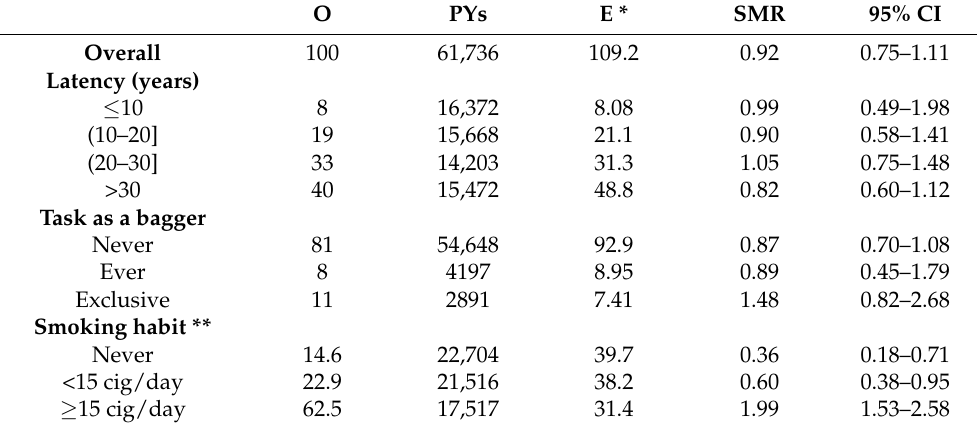
Table 2. Observed deaths (O), person years (PYs), expected deaths (E) and standardized mortality ratios (SMR) for lung cancer with 95% confidence intervals (95% CI) for the whole cohort, by latency, by task as a bagger and by smoking habit. O